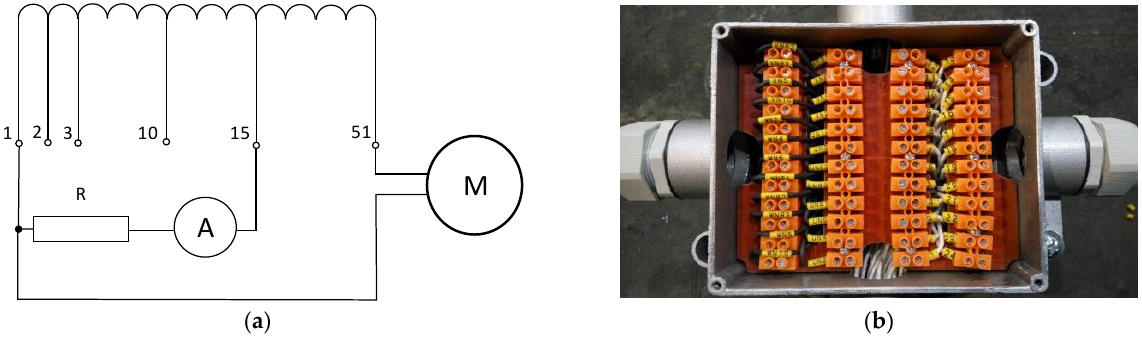
Figure 2. Test panel for the implementation of turn short-circuits: ( a ) wiring diagram of stator coil terminals; ( b ) v iew of the terminal strip installed in the motor’s terminal box .